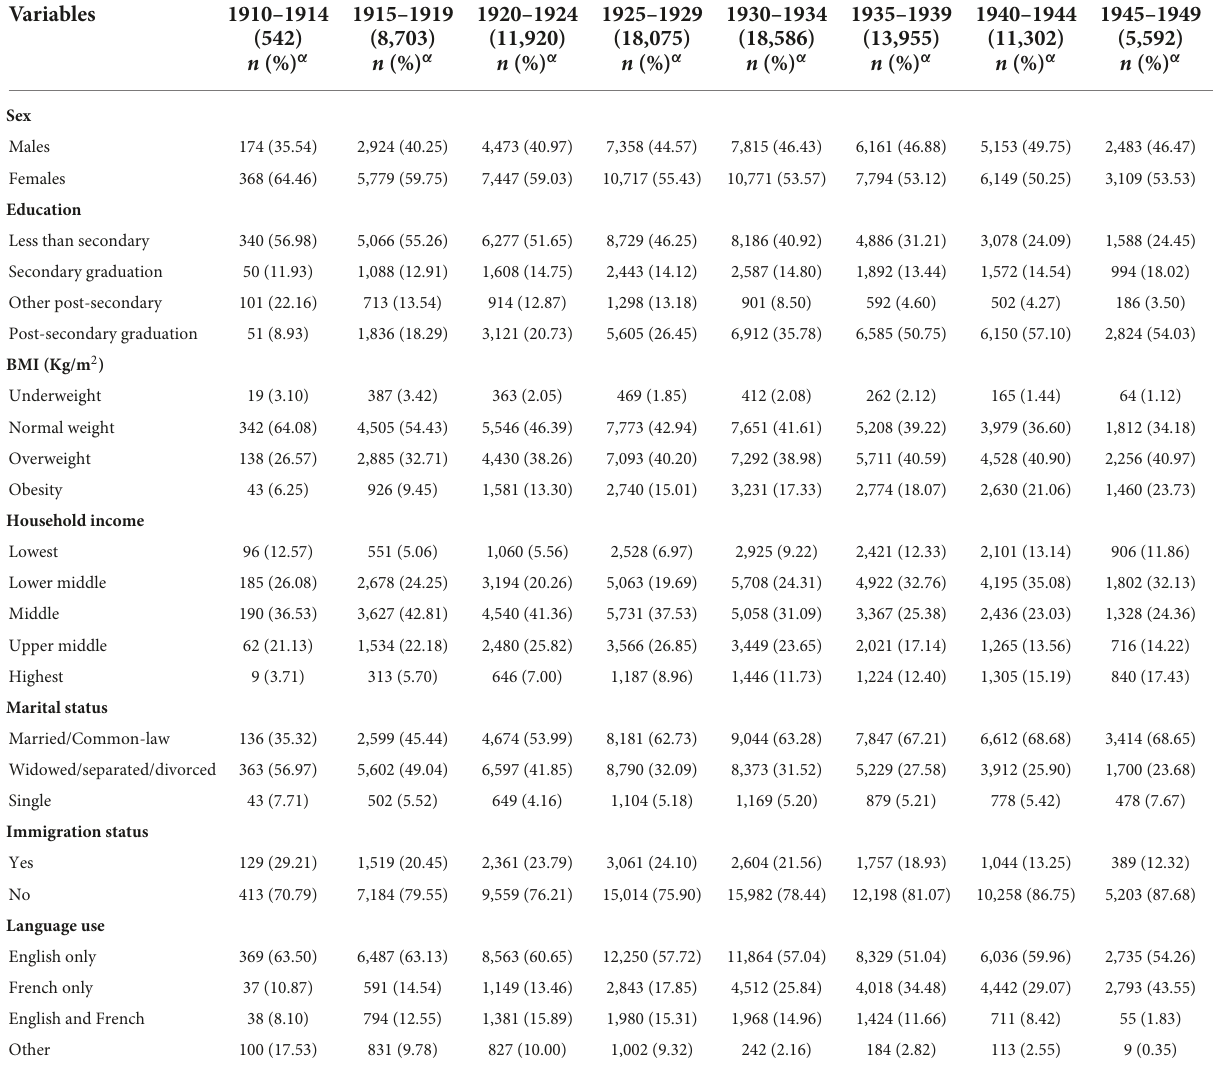
TABLE 1 Characteristics of the Canadian residents 65+ across the eight birth cohorts from 1910s to